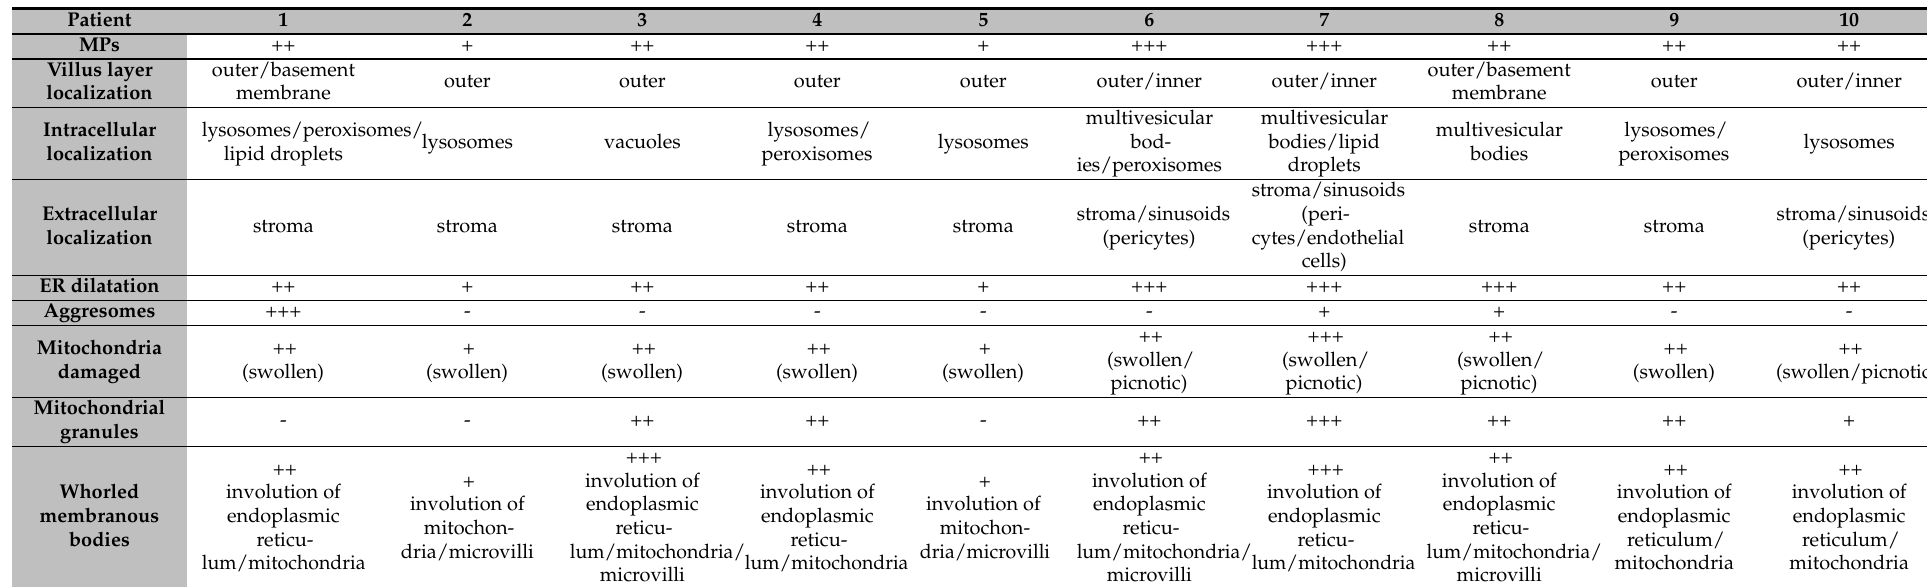
Table 2. Presence of MPs in ultrathin sections of ten samples of human